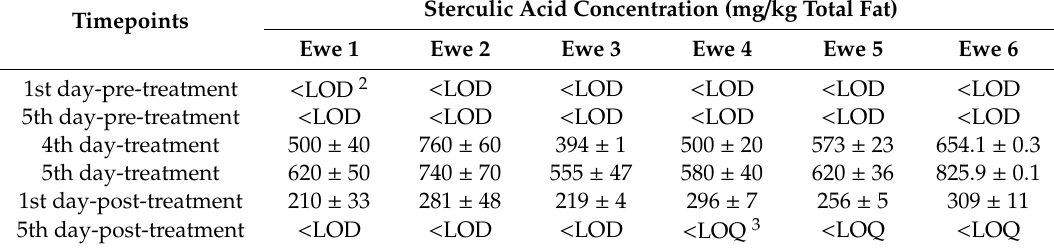
Table 2. Sterculic acid concentration (mg / kg total fat) 1 detected in each ewes’ milk fat samples by